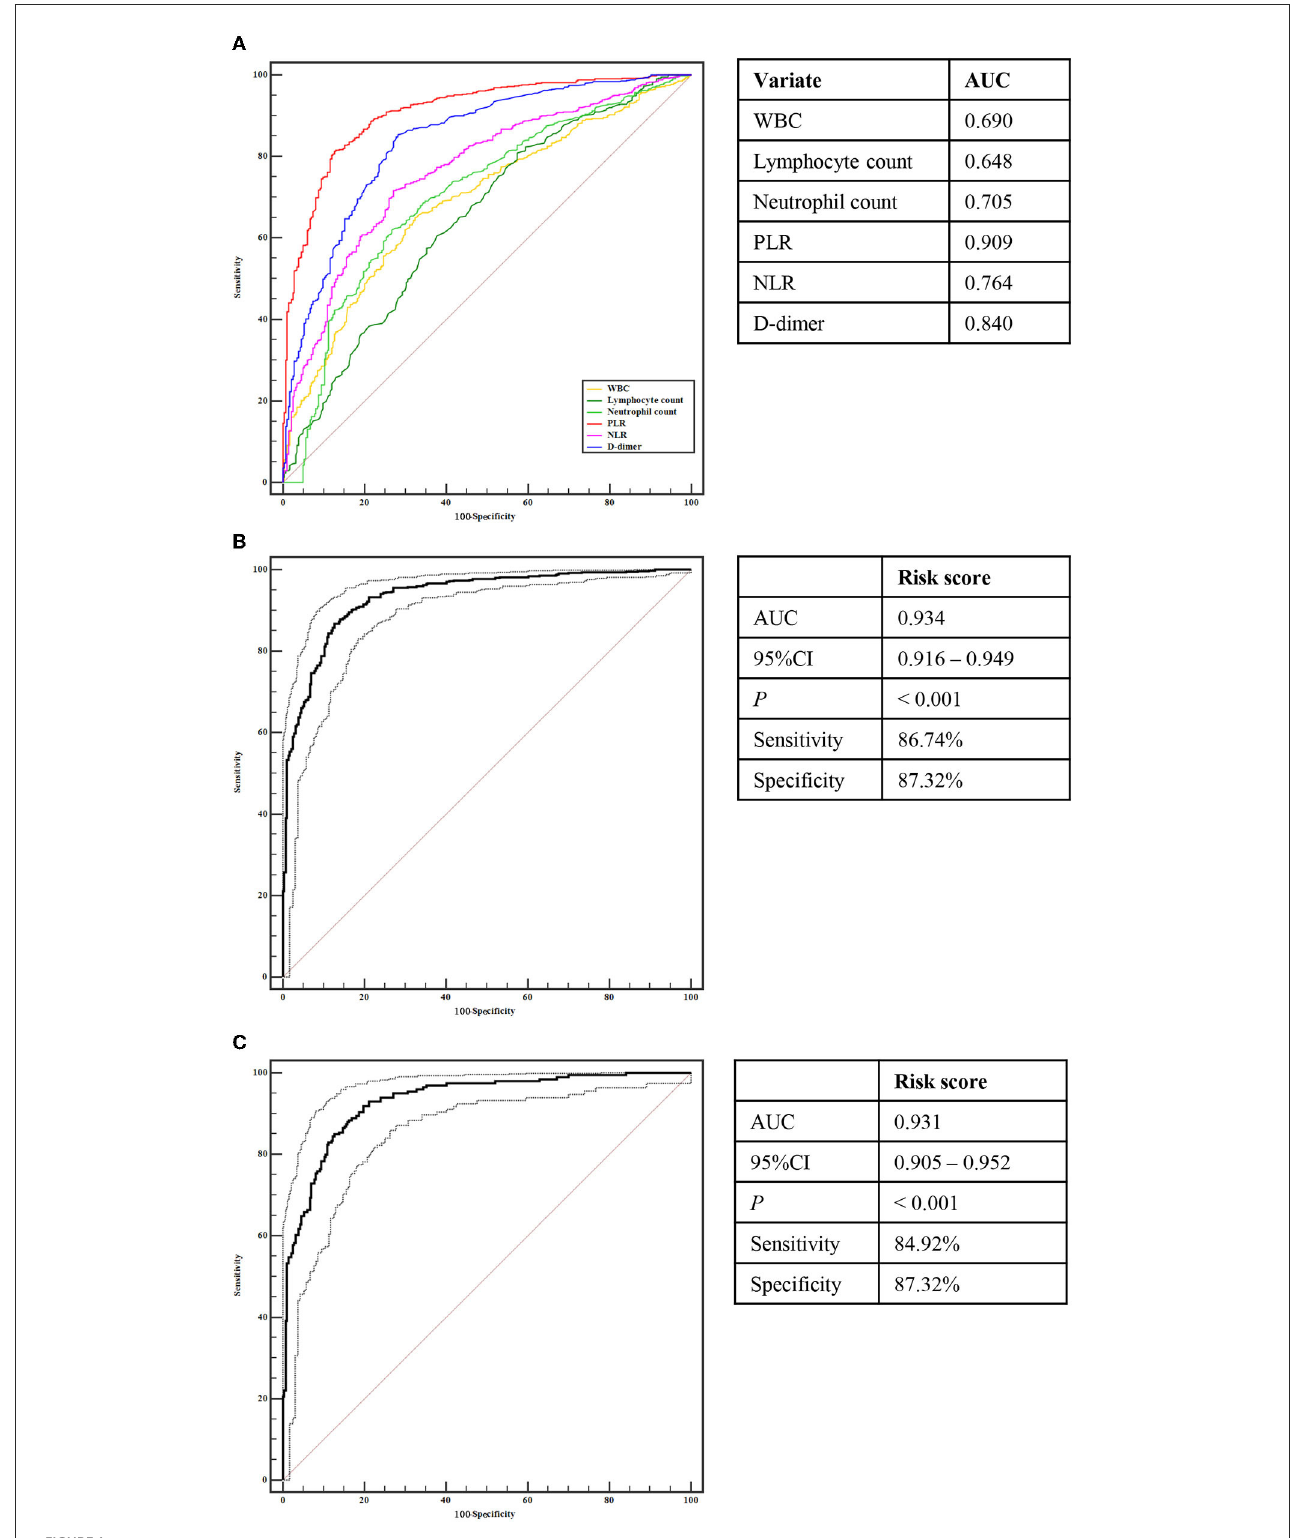
FIGURE1 Receiver operating characteristic curve analyses. (A) Analyses of WBC, Lymphocyte count, Neutrophil count, PLR, NLR, and D-dimer for identifying CCE patients with from NVAF patients without stoke. (B) Analyses of the risk score for identifying CCE patients with from NVAF patients without stoke. (C) Analyses of the risk score for identifying initial CCE patients with from NVAF patients without stoke. CCE, cardiogenic cerebral embolism; NVAF, non-valvular atrial fibrillation; WBC, white blood cell count; PLR, platelet-to-lymphocyte ratio; NLR, neutrophil-to-lymphocyte